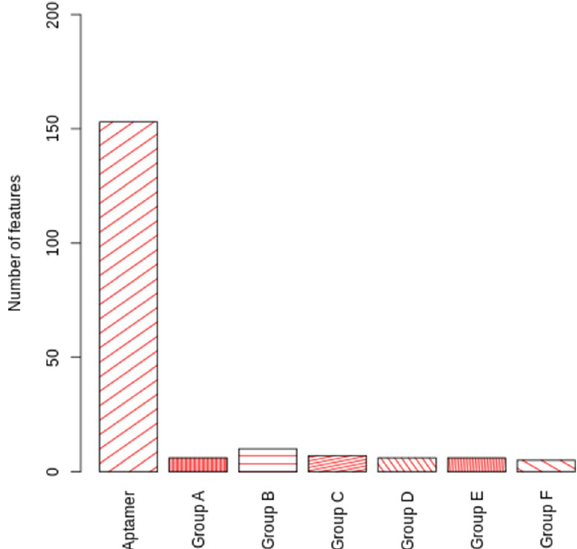
Figure 2. Distributions of the 193 optimal features. Where group A represents hydrophilicity and mass; group B represents polarity, molecular weight, and melting point; group C represents transfer free energy, buriability, and bulkiness; group D represent solvation free energy, relative mutability, and residue volume; group E represent volume, amino acid distribution, and hydration number; group F represent isoelectric point, compressibility and chromatographic index for protein